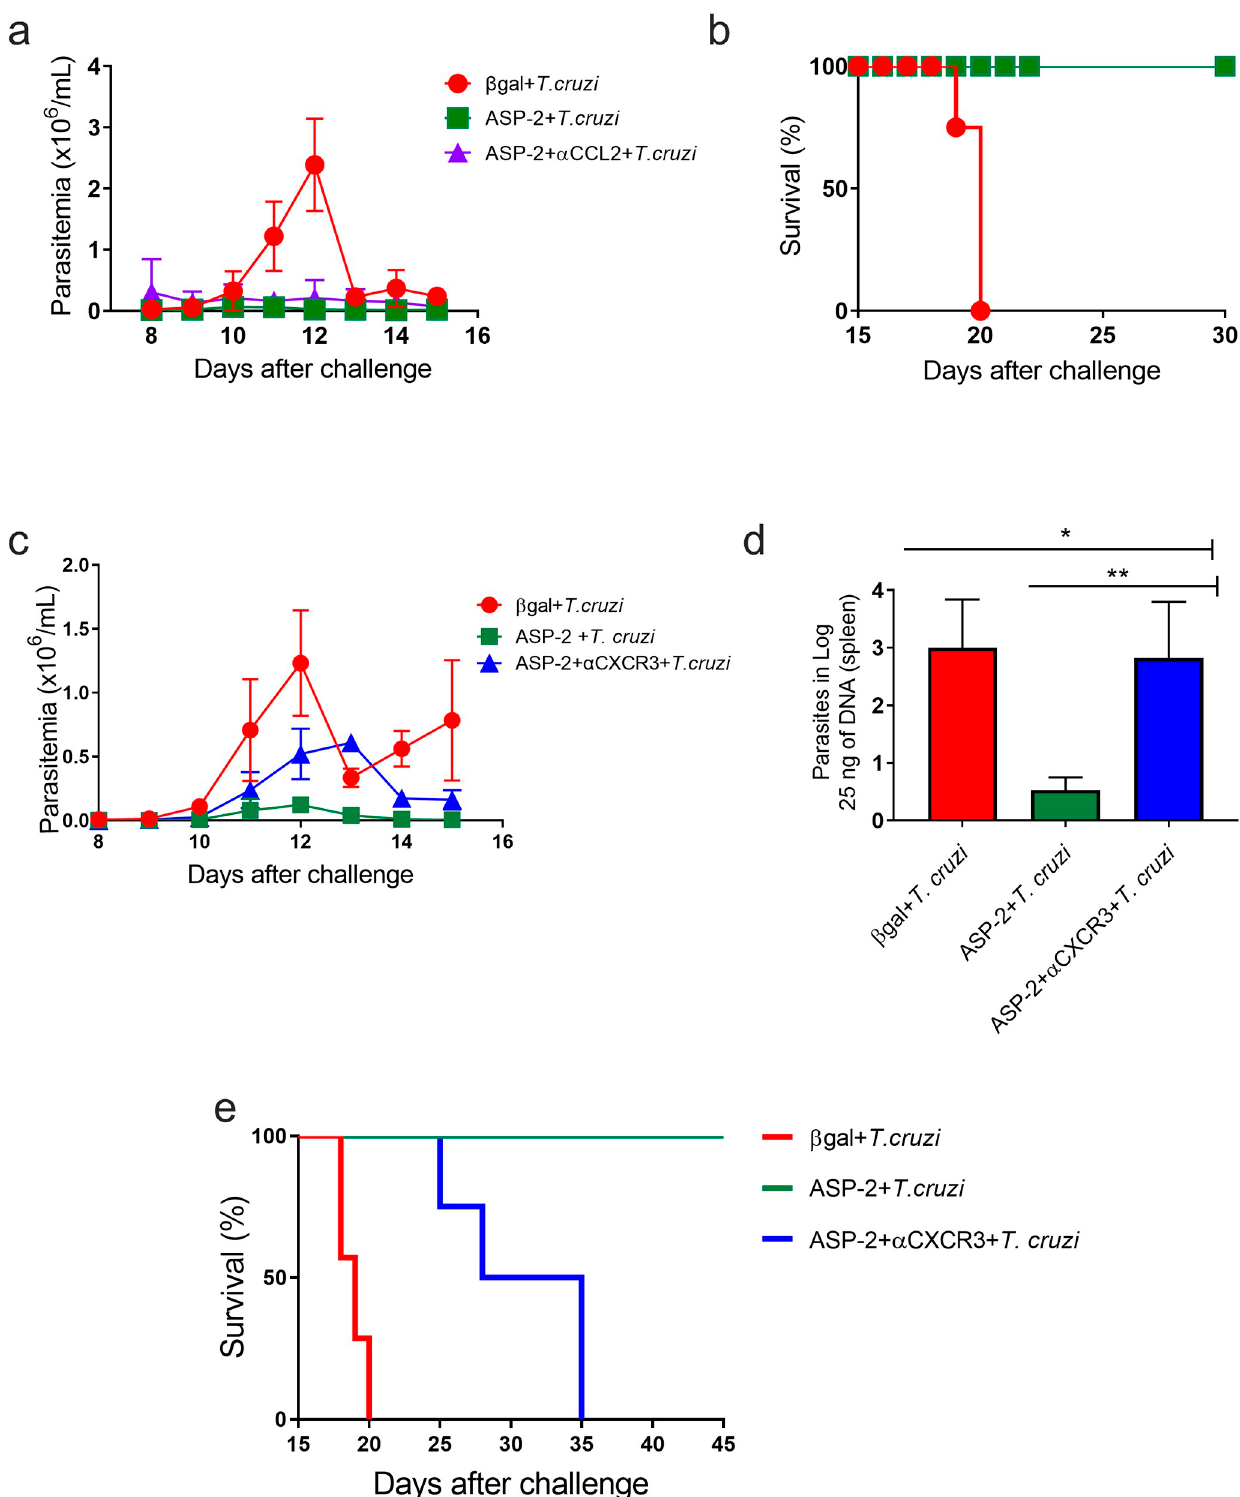
Fig 2. Parasitemia and survival of mice treated with anti-CCL2 or anti-CXCR3 antibody. A/Sn mice were immunized with the heterologous prime- boost protocol described earlier, and 15 days after the last dose of immunization, mice were challenged with 150 blood forms of Y strain of T . cruzi and treated, on the same day, with anti-CCL2 or anti-CXCR3 monoclonal antibodies. a-Linear parasitemia scale of β gal+ T . cruzi (red), ASP2+ T . cruzi (green)